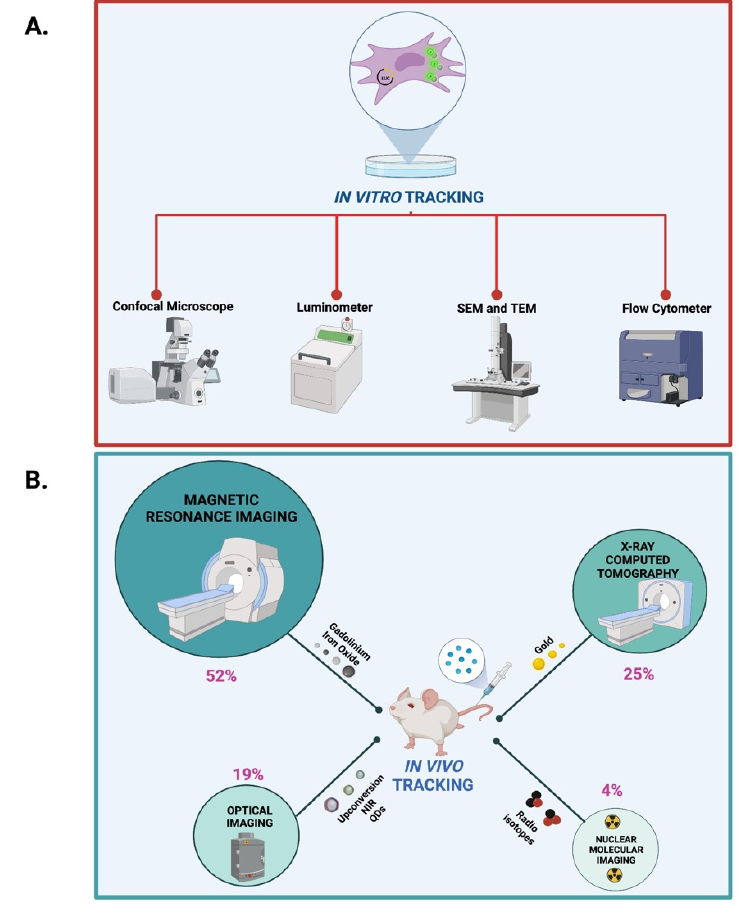
Figure 5. Methods and devices for in vivo and in vitro imaging of NPs. ( A ) In vitro tracking of NPs. ( B ) In vivo tracking of NPs. Percentage (%) refers to different types of imaging tools for NP tracking based on our literature survey. Figure created with BioRender. Available online: https://biorender.com/ (accessed on 25 March 2022).